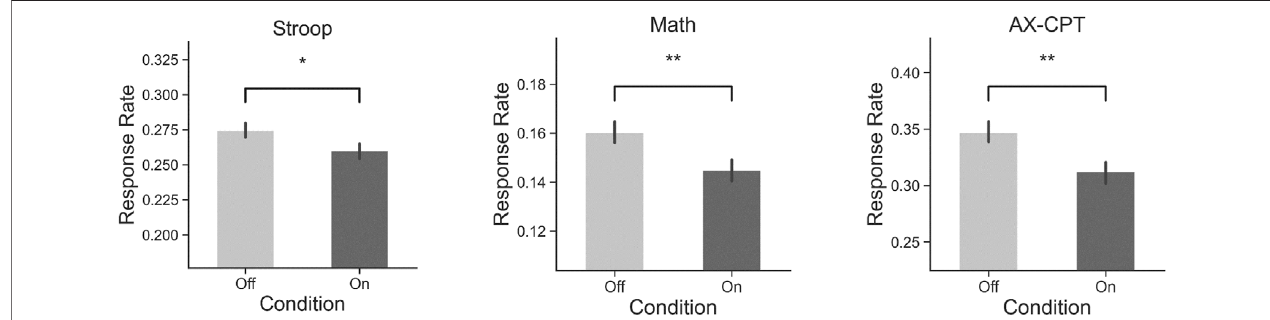
FIGURE 4 | Bar graphs showing the proportion of task-based responses during distractor On or distractor Off periods of time. Error bars represent 95% con fi dence intervals after removal of between-subject variability. Statistical signi fi cance denoted by “ * ” for p ≤ 0.05 and “ ** ” for p < 0.001. In all tasks, the number of problems responded to decreased when distractors were present compared to when they were absent. The consistency across tasks suggests that distractors interfered with performance irrespective of which task was being performed.